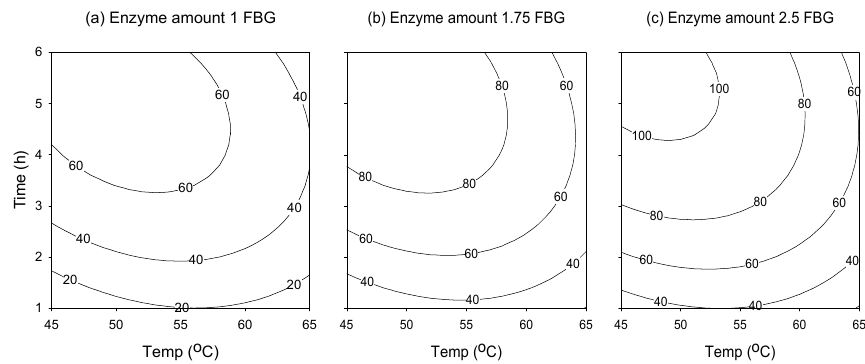
Figure 2. Contour plots of conversion of piceid to resveratrol with varying reaction temperature and times at constant enzyme amounts of ( a ) 1, ( b ) 1.75 and ( c ) 2.5 FBG. The numbers inside the contour plots indicate conversions under given reaction conditions.